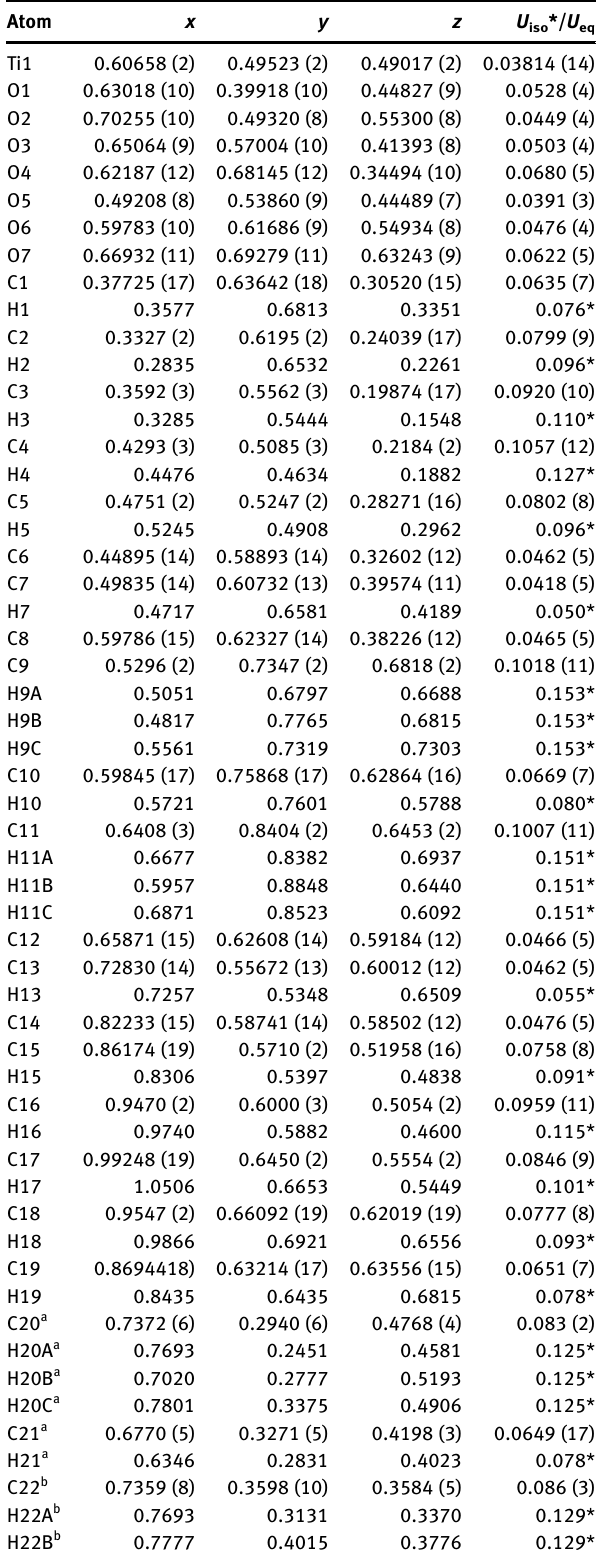
Table  : Fractional atomic coordinates and isotropic or equivalent isotropic displacement parameters (Å 